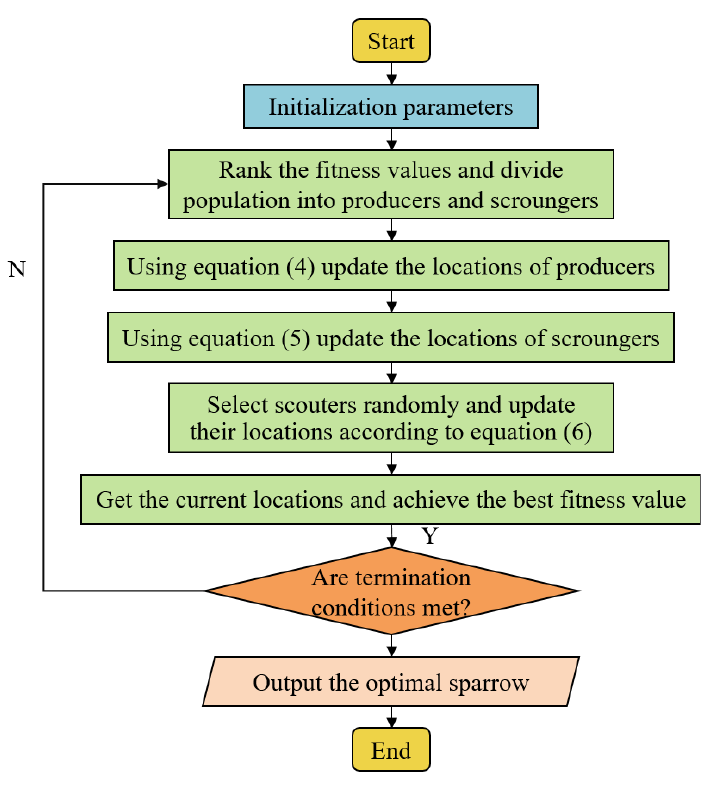
Figure 3. The flowchart of SSA.